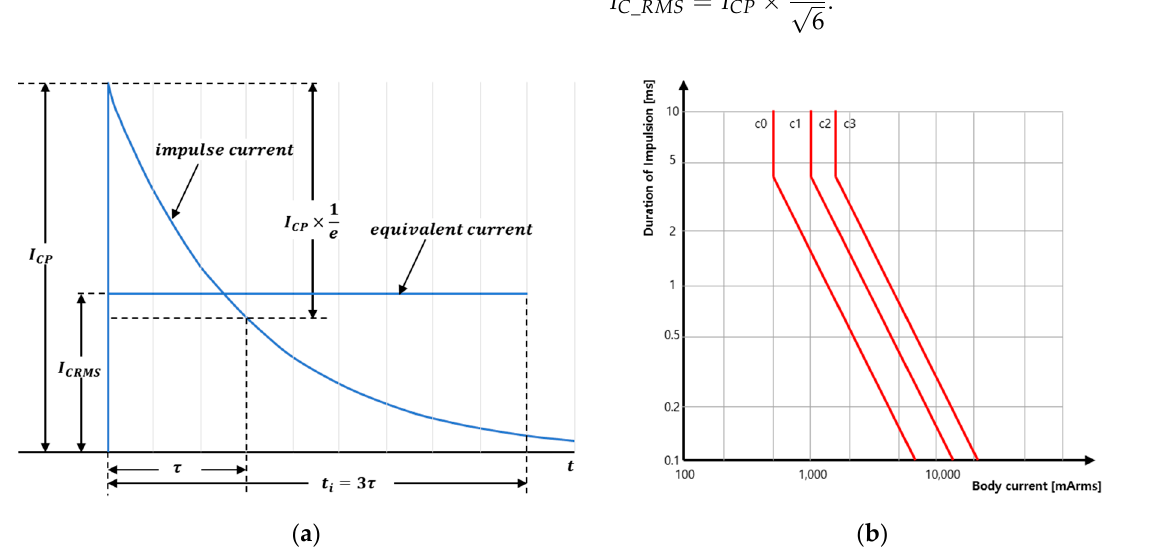
Figure 6. Impulse current characteristics caused by capacitor discharge: ( a ) Equivalent DC current of impulse current; ( b ) Probability of fibrillation risk for current flowing in the path from the left hand to feet in IEC 60479-2. Zone